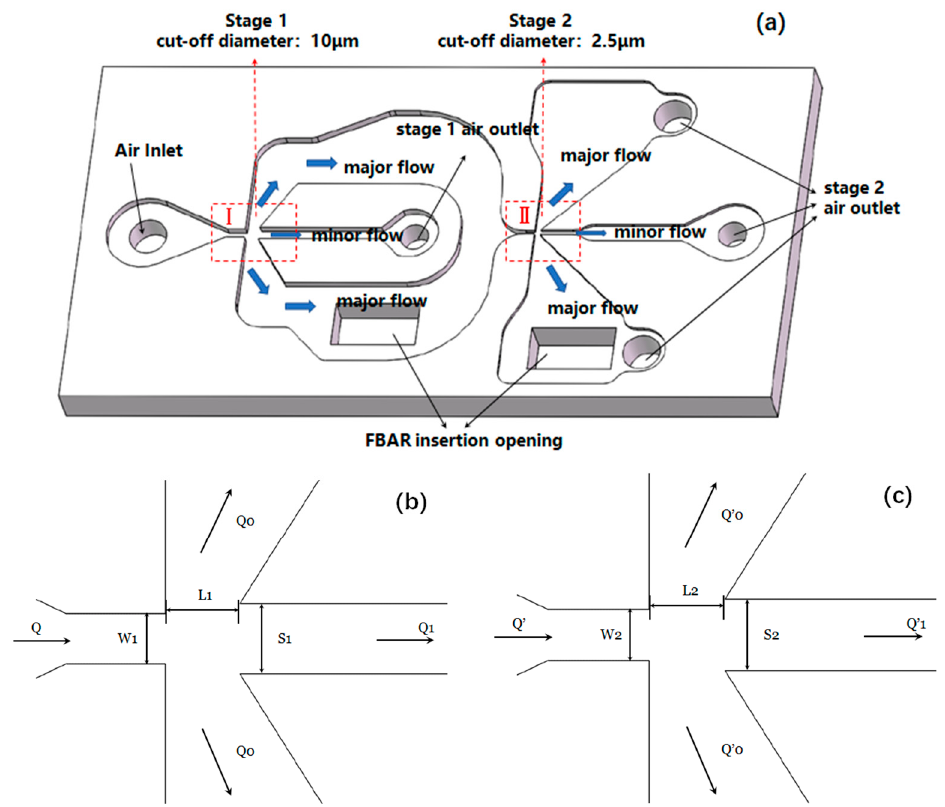
Figure 2. The configuration of the PM air-microfluidic grading channels and VIs ( a ). Partial enlargement of VI in PM microfluidic chip at I ( b ) and II ( c ), including the air inlet width and depth, the width of the main flow channel and the second channel, the volumetric flow of gas at the inlet and the split ratio.